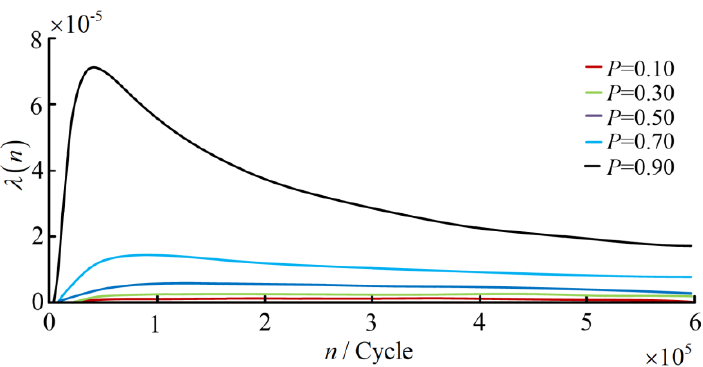
Figure 9. Failure rate affected by parameters of material.